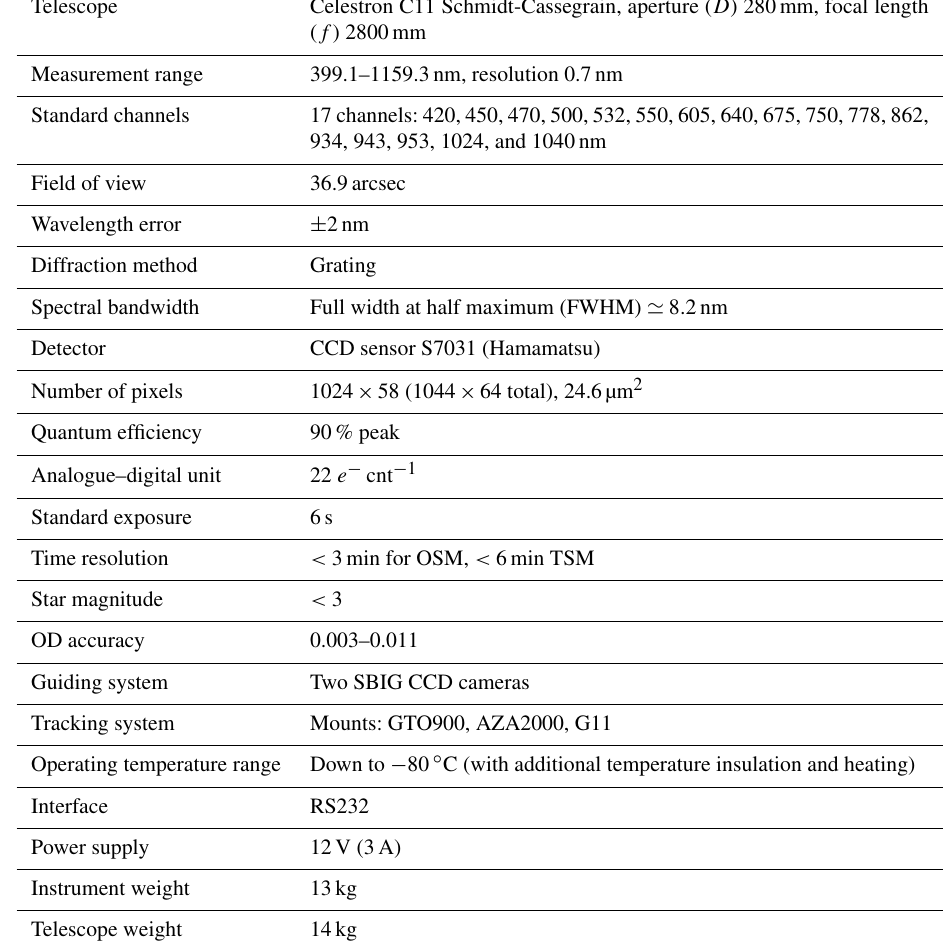
Table 1. Technical parameters of the SPST09 starphotometer.